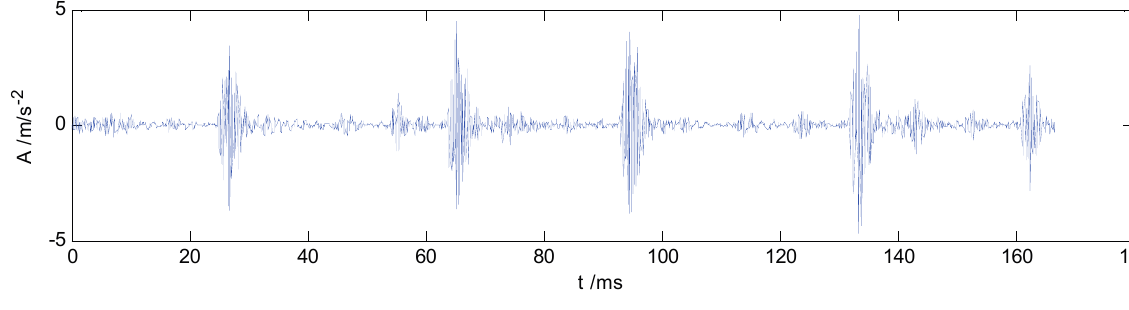
Figure 3. The original ORF vibration